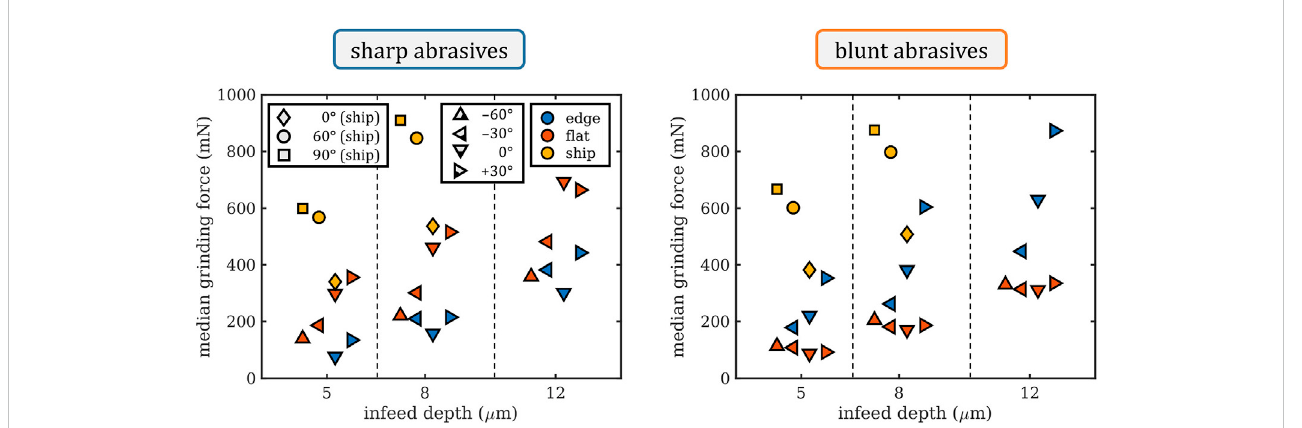
FIGURE 4 Median grinding forces for sharp (left) and blunt (right) abrasives (3 abrasive grain orientations; edge, fl at, and ship). Symbol colors denote abrasive orientations, and symbol shapes the rake angle. Within each category of infeed depth, the individual rake angles are also staggered from left to right in ascending